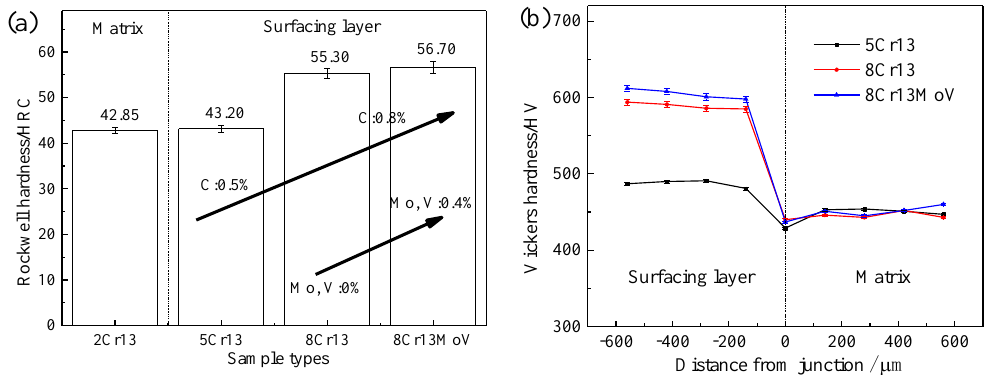
Figure 7. Hardness test of the substrate and di ff erent kinds of surfacing layers. ( a ) Rockwell hardness; ( b ) Vickers hardness.